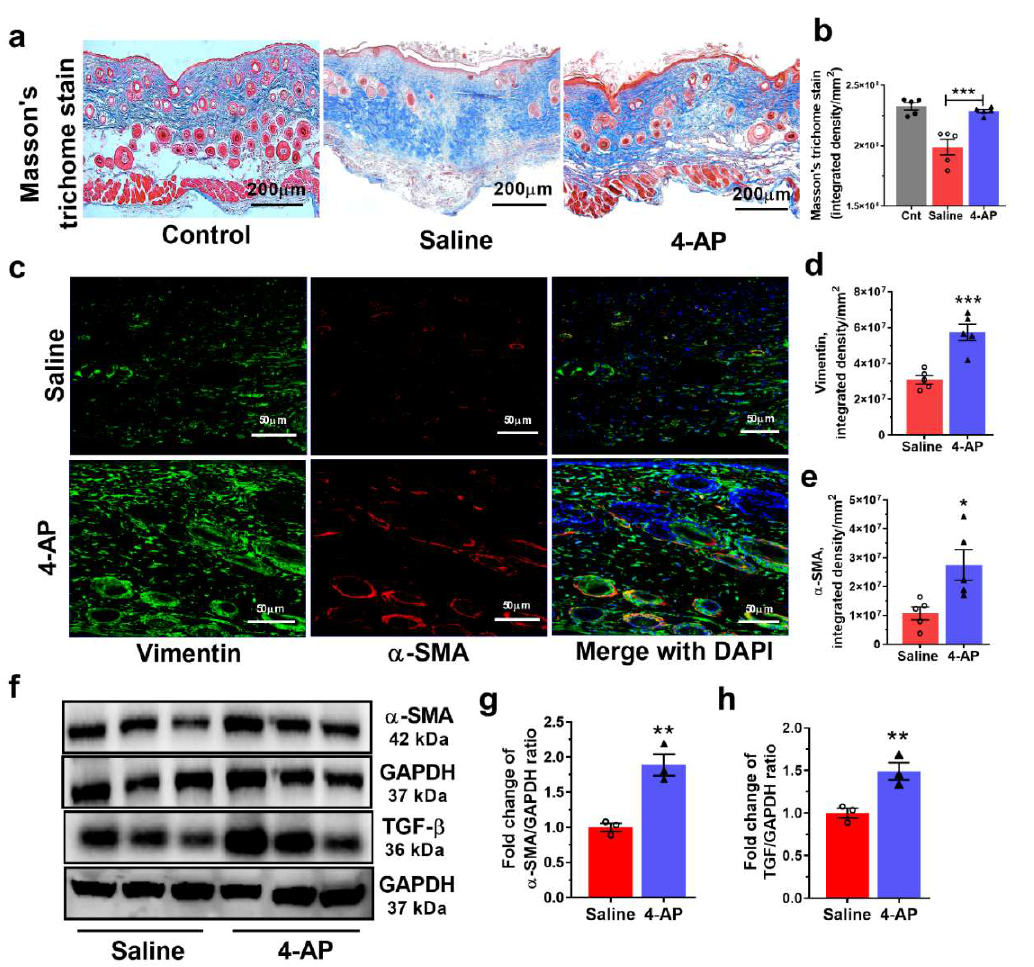
Figure 3. 4-AP treatment increases fibroblast and myofibroblast numbers and levels of transforming growth factor- β . ( a ) Representative Masson’s trichrome stained images of healing control skin and full-thickness excisional wound of saline-control and 4-AP-treated skin tissue at day 14 (PWD14). Scale bars = 200 µ m. ( b ) Collagen density quantified as average blue pixel density per area in wound healing tissue harvested on day 14 (PWD 14). Data represents 10 images from 5 differ- ent mouse wounds and are shown as mean ± SEM, n = 5 animals per group, statistical signifi- cance indicated by asterisks (O = saline mouse data points, ∆ = 4-AP treated mouse data points, *** = p between 0.001 and 0.0002 vs. saline). ( c ) Co-immunofluorescence staining of vimentin (green), α -SMA (red), and nuclear stain (DAPI-blue) in saline control and 4-AP-treated skin wound sections at day 14. Scale bars = 50 µ m. ( d , e ) Quantification of vimentin and α -SMA protein stain- ing intensity (integrated density). Data represent 20 images from 5 different mouse wounds and are shown as mean ± SEM, n = 5 animals per group, statistical significance indicated by asterisks (O = saline mouse data points, ∆ = 4-AP treated mouse data points, * = p between 0.01 and 0.05, and *** = p between 0.001 and 0.0002 vs. saline). ( f ) Representative Western blots of α -SMA and TGF- β levels. ( g , h ) Quantitation of α -SMA and TGF- β levels to normalized to GAPDH (fold change mean ± SEM, n = 3 animals per group, statistical significance indicated by asterisks (O = saline mouse data points, ∆ = 4-AP treated mouse data points, ** = p between 0.01 and 0.001vs.